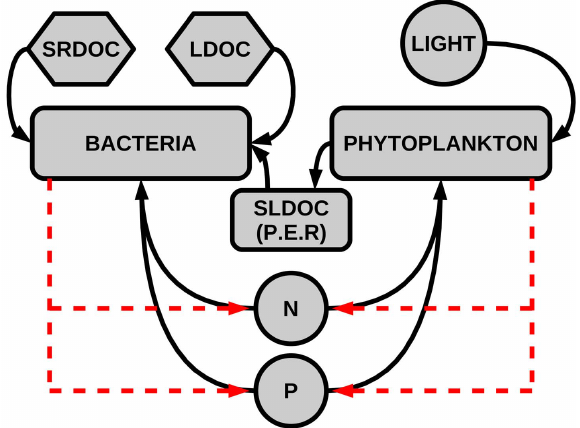
Fig. 1: Diagram representing a simplified system of compe- Fig. 1. Diagram representing a simplified system of competi- tition and commensalism between bacteria and phytoplank- tion and commensalism between bacteria and phytoplankton. Both ton. Both groups are competing for nutrients (N,P) but while groups are competing for nutrients (N,P) but while phytoplankton phytoplankton relies on light to produce carbon, bacteria uses relies on light to produce carbon, bacteria uses three organic carbon three organic carbon sources that originated either from pho- sources that originated either from photosynthetic extracellular re- lease (PER) or from grazing and mortality. PER was considered a tosynthetic extracellular release (PER) or from grazing and semi-labile DOC source (SLDOC). 40% of DOC from grazing and mortality. PER was considered a semi-labile DOC source mortality was considered semi-refractory (SRDOC) and 10% was (SLDOC). 40% of DOC from grazing and mortality was con- considered as labile (LDOC). sidered semi-refractory (SRDOC) and 10% was considered as labile (LDOC).